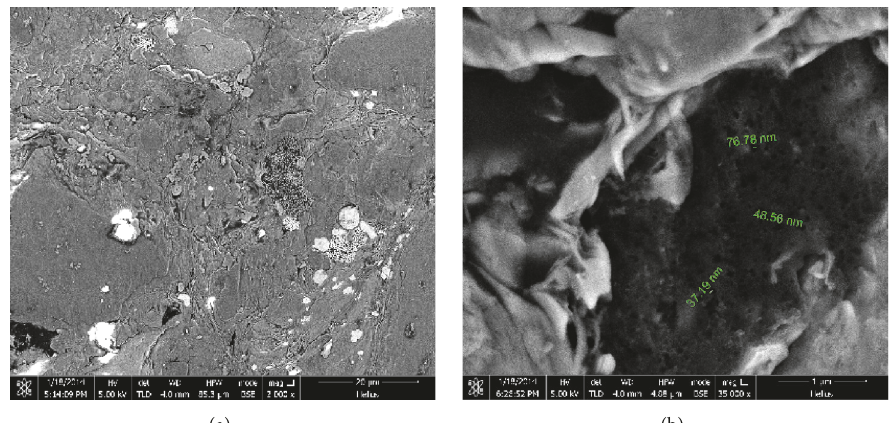
Figure 1: Backscattered electron images of shale samples: (a) SEM image of a lower resolution; (b) SEM image of a higher resolution.